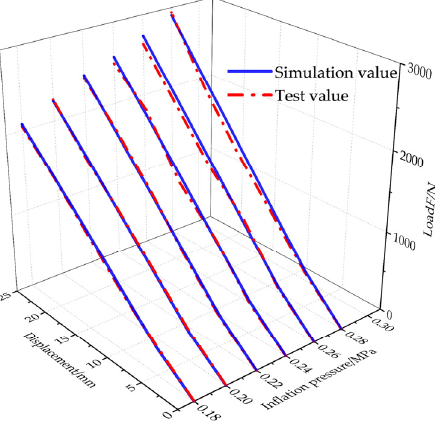
Figure 6. Radial stiffness curve. Table 1. Experimental and simulation results of tire radial stiffness.